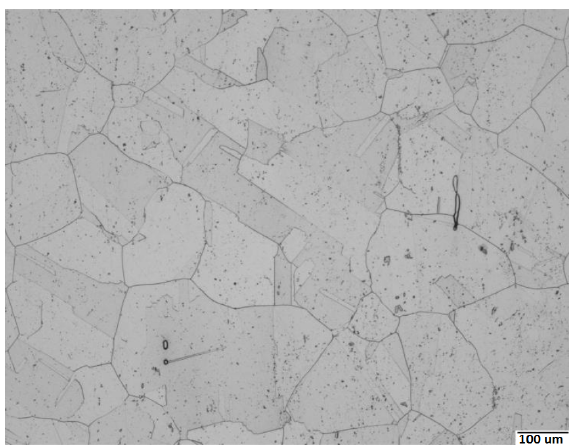
Figure 1. Microstructure of the studied 316Nb steel observed using optical microscopy: austenite grains, residual δ ferrite (elongated particles), and primary Nb(C,N) carbonitrides (dots, not well resolved) can be seen (electrolytical etching using 60 mL of HNO 3 and 40 mL of water (1 V, 120